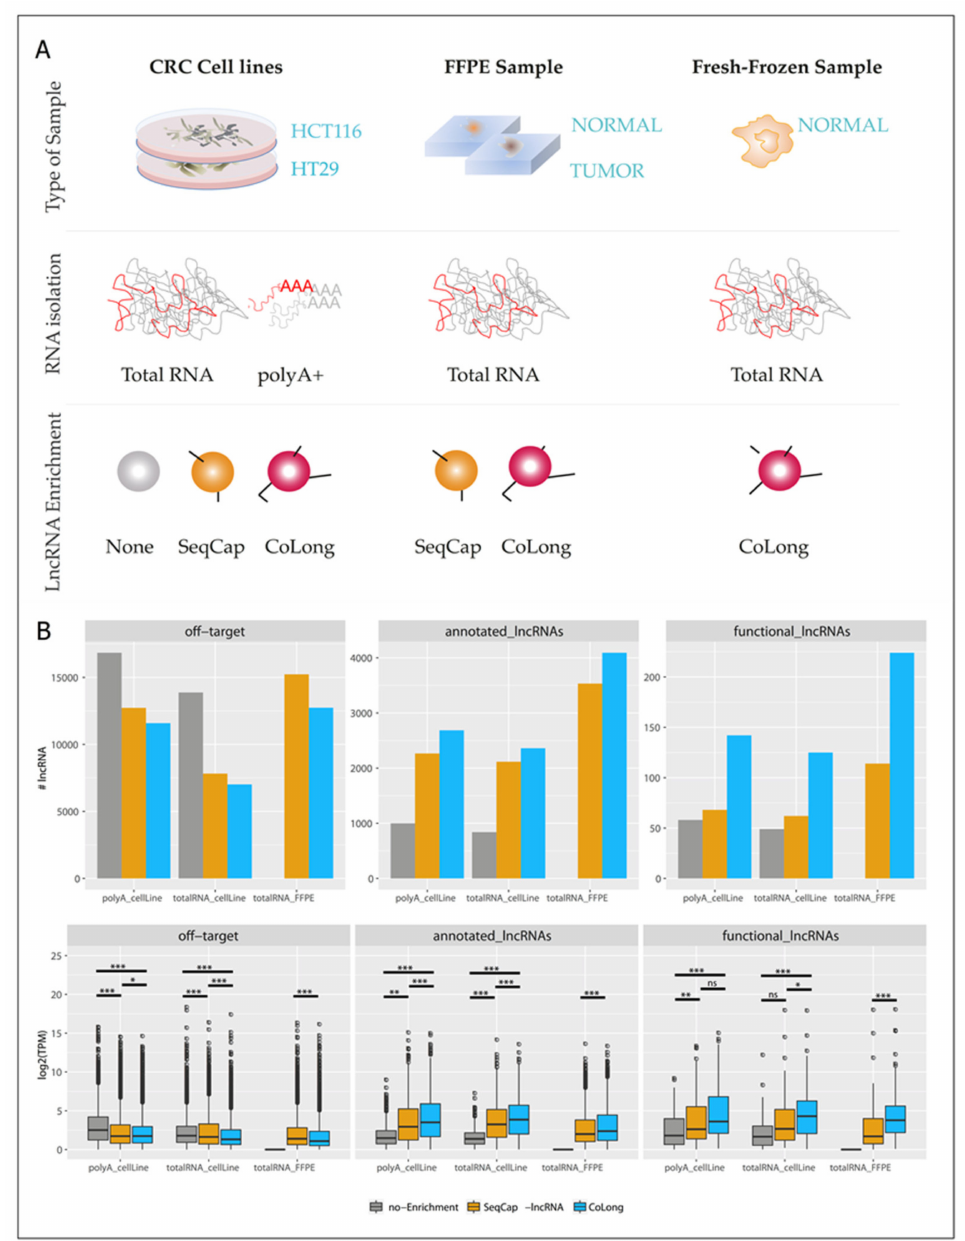
Figure 1. Validation of probe-set SeqCap enrichment with the CoLong design. ( A ) Scheme summarizing the experimental strategy undertaken to pursue the validation of the CoLong probe set. In brief, we used three types of sample source (fresh colorectal cancer (CRC) cell lines, formalin-fixed, para ffi n-embedded (FFPE) samples from CRC patients (tumor and normal tissues), and fresh-frozen samples from normal tissue of candidates for colonoscopy. We isolated total RNA (and polyA + selection in CRC cell lines) and compared the performance of lncRNA detection: in the absence of enrichment (none), with the SeqCap enrichment commercial design, and with the CoLong design. ( B ) Comparison of gene quantification between the two enrichment protocols (SeqCap-lncRNA [25] and CoLong (present study)) and without enrichment, using total RNA and polyA enrichment in CRC cell lines and FFPE samples. Top: number of lncRNAs with TPM > 1 detected in each condition; bottom: median log2(TPM) values for the replicates in each experiment. P -values were calculated using a Wilcoxon test: p -value > 0.05: not significant (ns), p -value < 0.05: *, p -value < 0.01: **, p -value < 0.001: